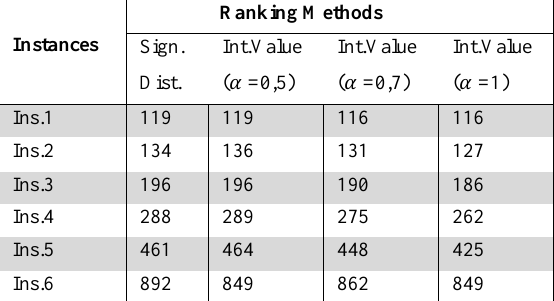
Table 1. The solutions obtained by signed distance and